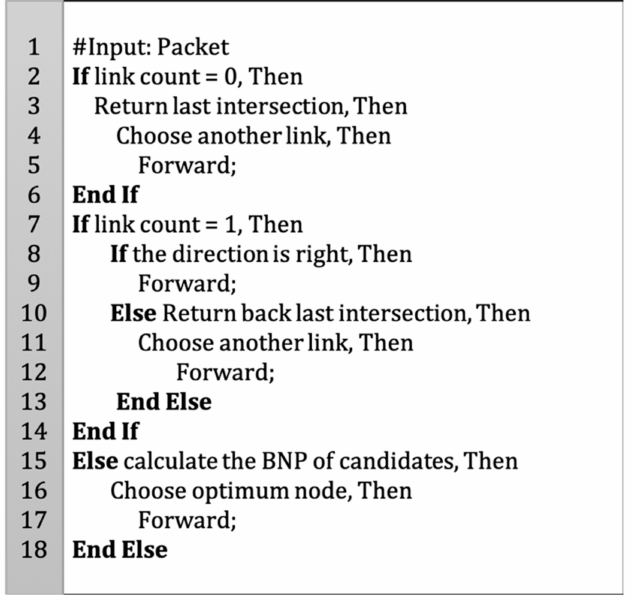
Figure 3. Pseudocode for next-hop road segment